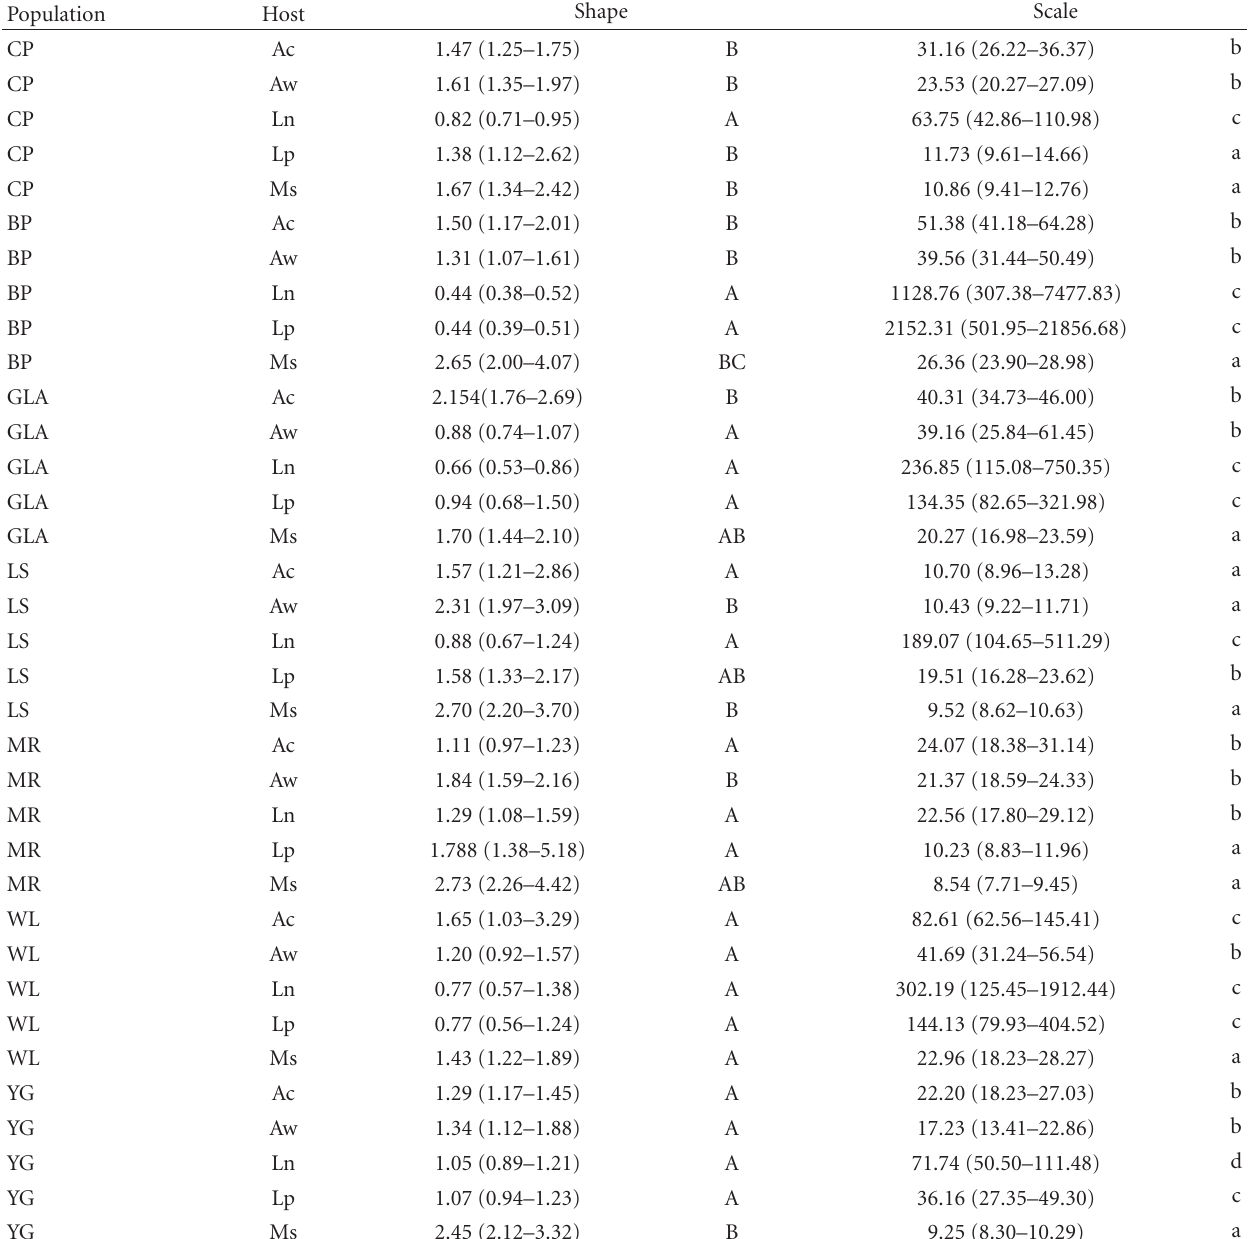
Table 4: Survival curves for each host-population combination. A weibull distribution was fitted to each combination with 1000 bootstrap replicates. We report shape and scale parameters along with bootstrapped confidence intervals. Upper case and lower letters following shape and scale values correspond to 95% confidence intervals that do not overlap (upper case letters for shape and lower case letters for scale) within populations based on the thousand bootstrapped replicates. See Figure 3 for graphical representation of survival